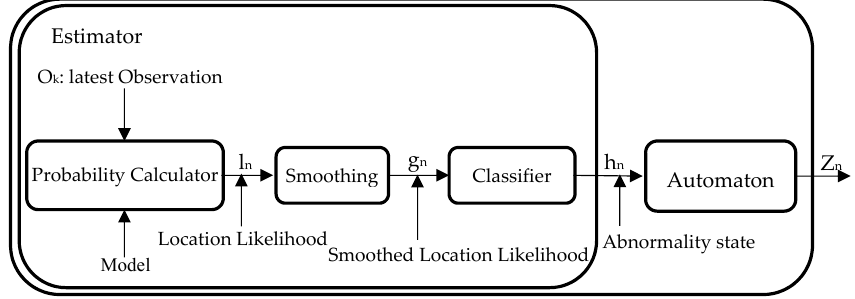
Figure 3. Detection Module—internal structure.